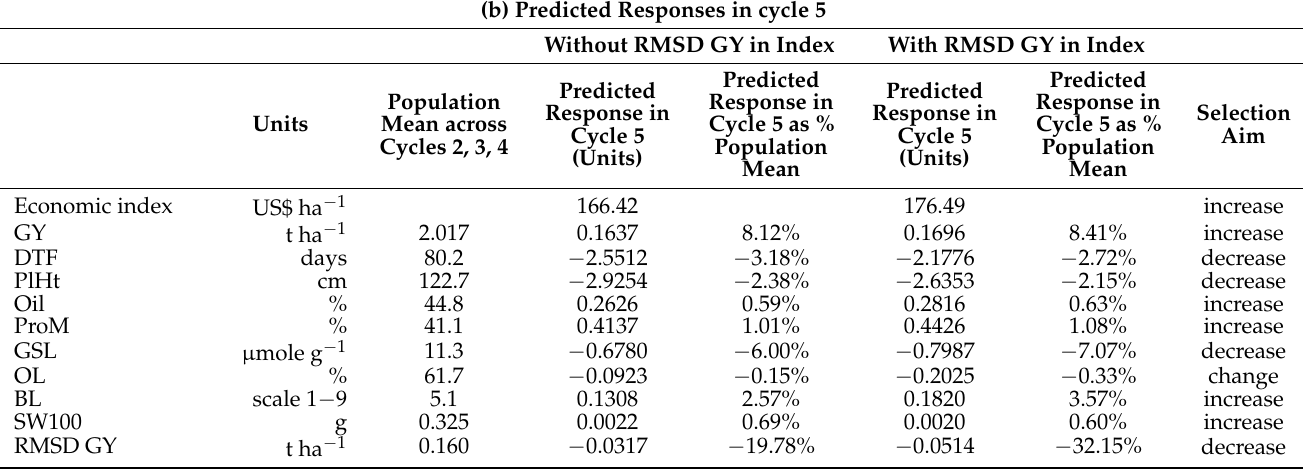
Table 5. Cont. (b) Predicted Responses in cycle 5